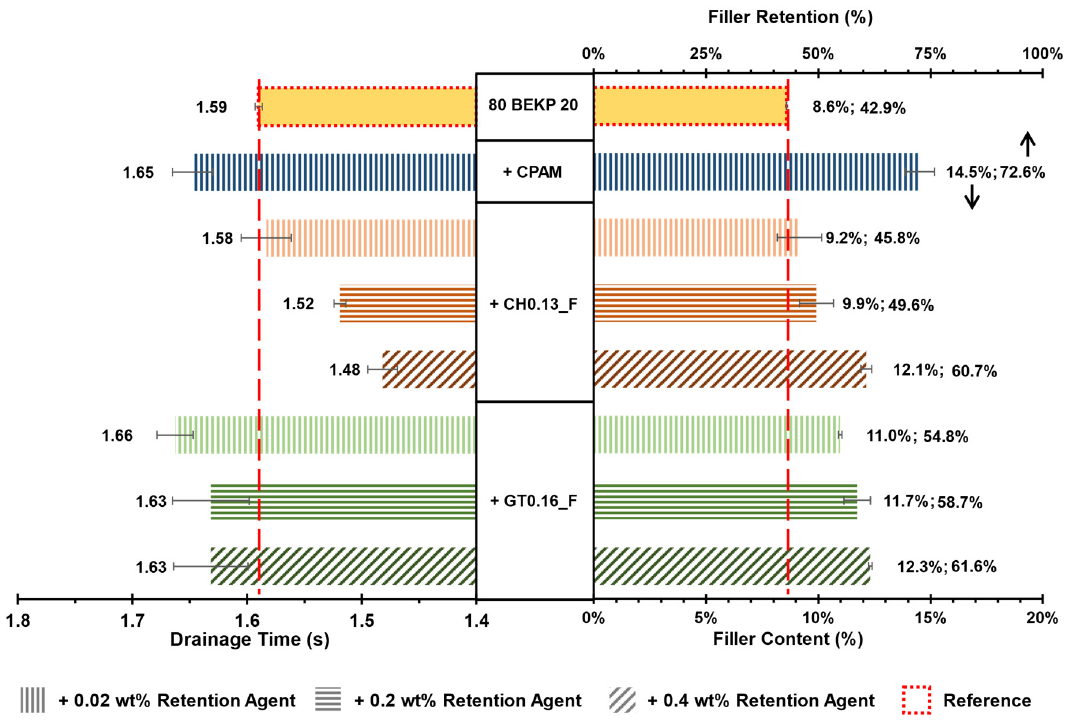
Figure 8. Drainage time, filler content and filler retention as a function of dosage of the best flocculants.